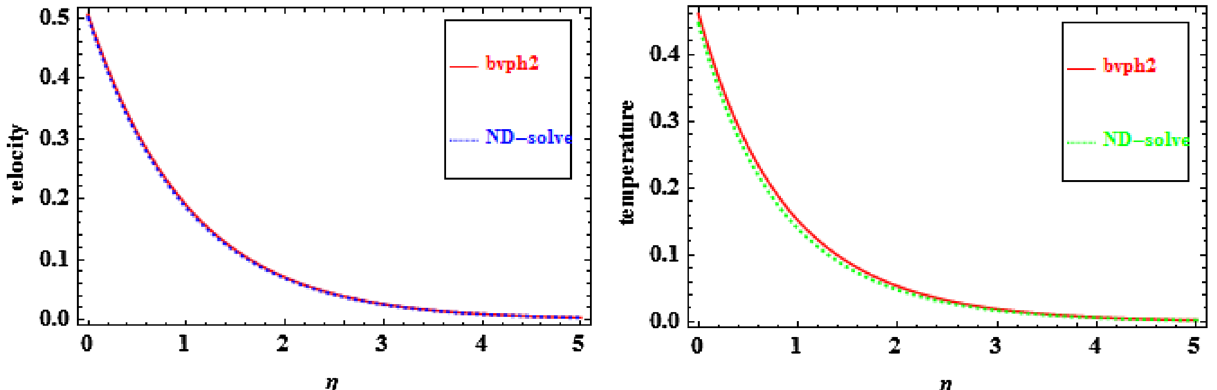
Figure 2. Comparison of bvph2 and ND-solve.